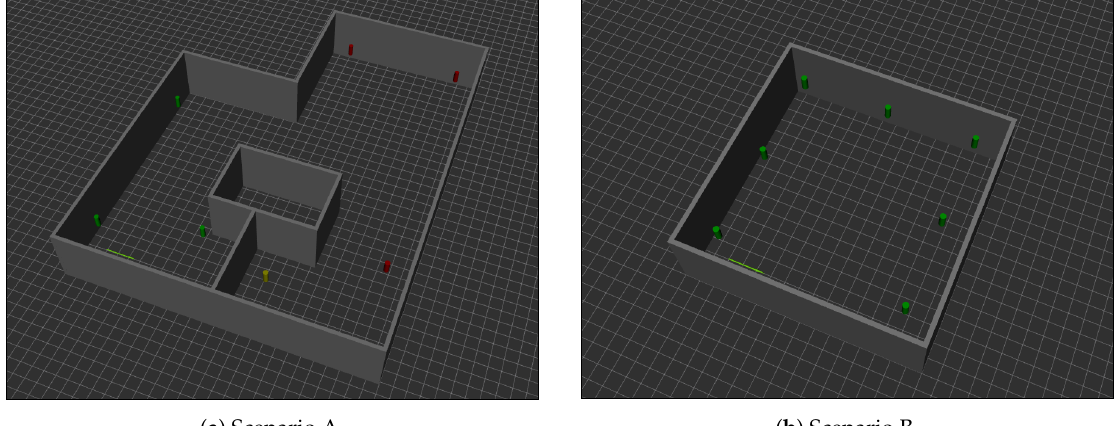
Figure 8. The two simulated